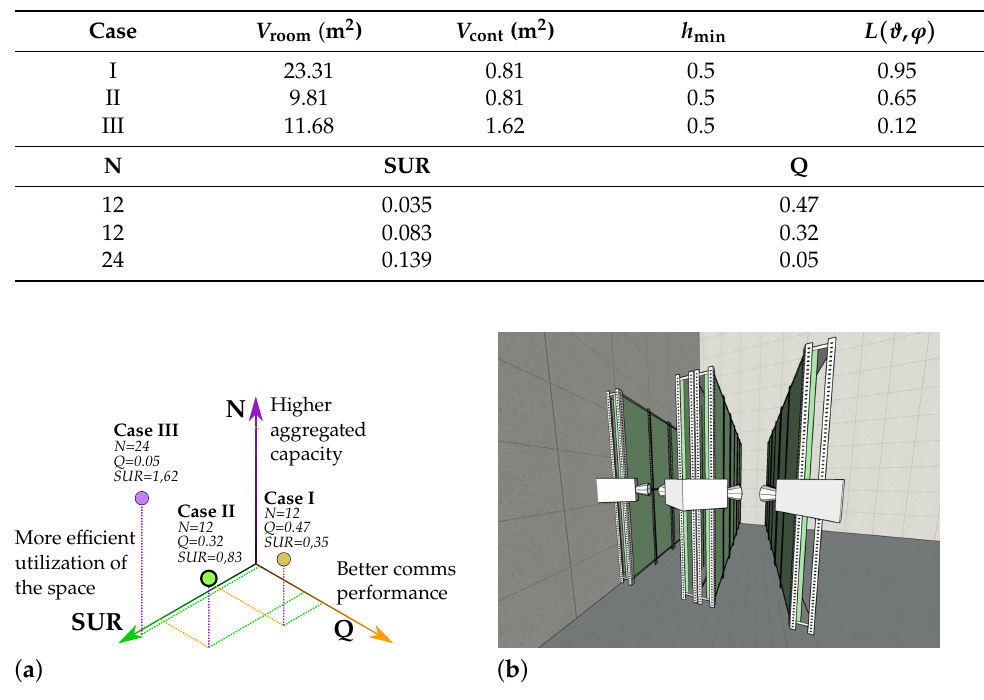
Table 4. Metric values obtained for the three arrangements.